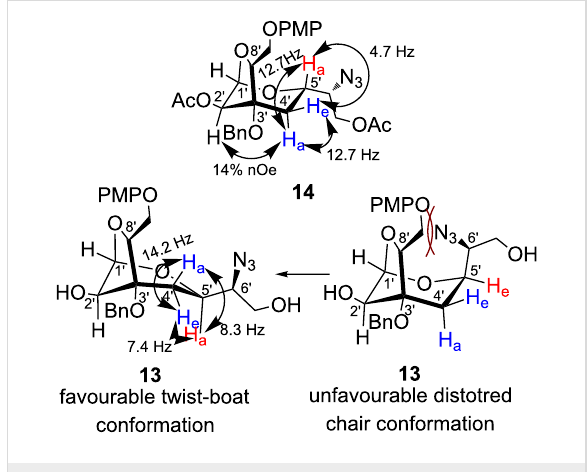
Figure 2: Conformational analysis of 13 and 14 .